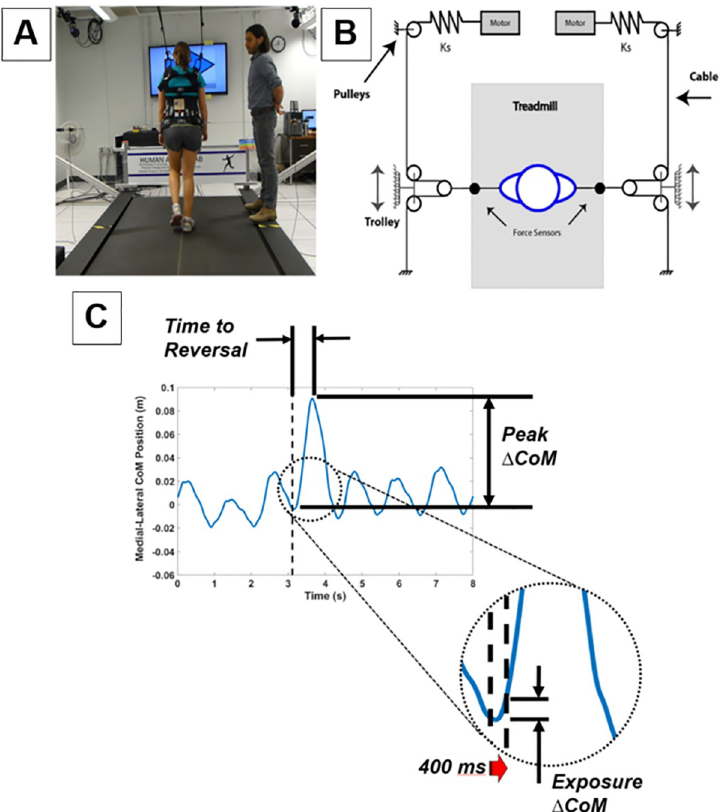
Fig 1. Cable-robot setup (a) and design (b) for applying lateral perturbations to the CoM (adopted from Major et al 2018 [26]), and measured variable definitions (c) according to temporal medial-lateral COM